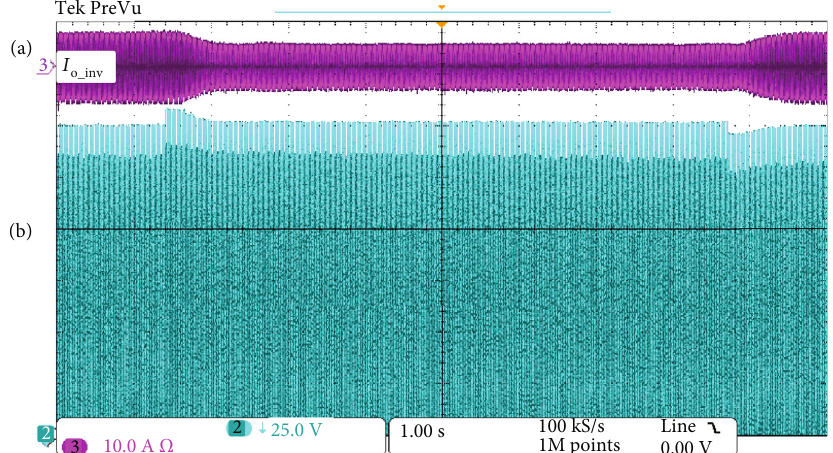
Figure 13: System response under transformer voltage variation (increment): (a) current in residence 11 ( I , 25V/div). Time 1 s/div. residence 11 ( V 11